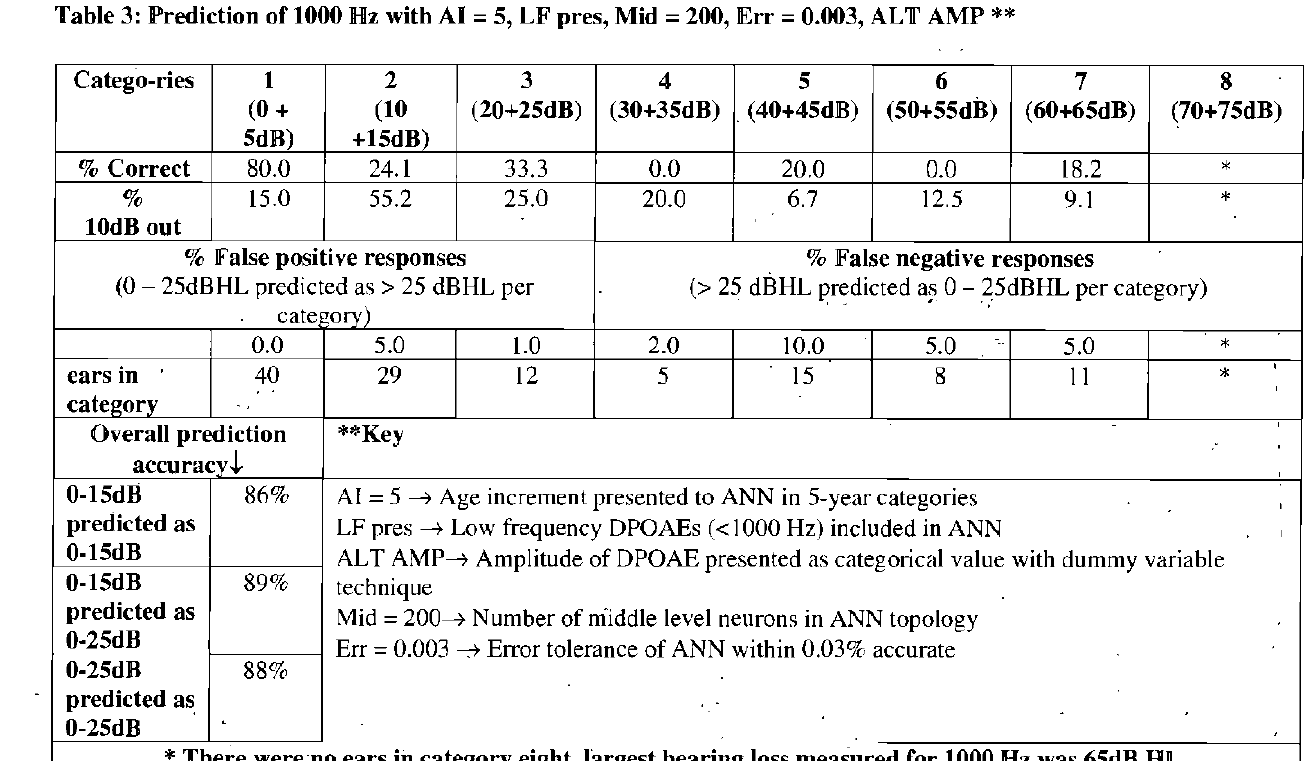
Table 3: Prediction of 1000 Hz with Al = 5, LF pres, Mid = 200, Err = 0.003, ALT AMP ** Catego-ries